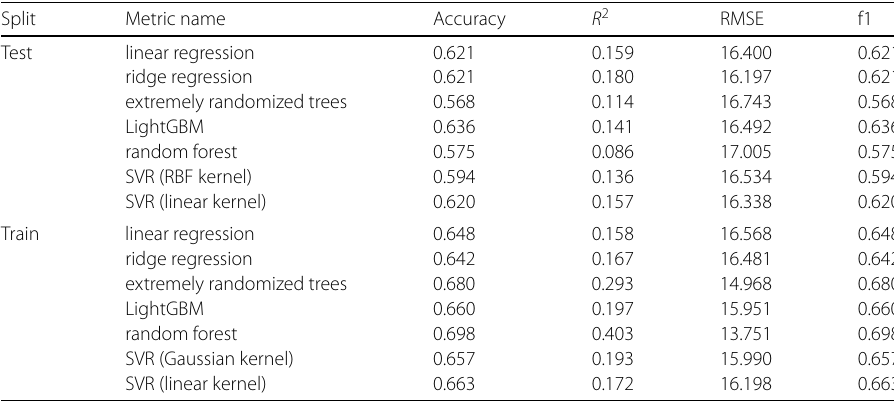
Table 6 Performance comparison of all models on the training and testing set. The R 2 score and root mean squared error (RMSE) indicate how well we can fit the true reading progress. Accuracy measures if the direction of progress is correctly predicted and the f1 score is a combination of precision and recall. Since both, accuracy and f1 score are the same, we know that precision (positive predictive value) and recall (sensitivity) have the same value. For all, except RSME, holds that higher values indicate a better fit. Test and train values are close to one another, which suggests that no strong over-fitting occurred. We finally chose linear regression and ridge regression as final models Split Test